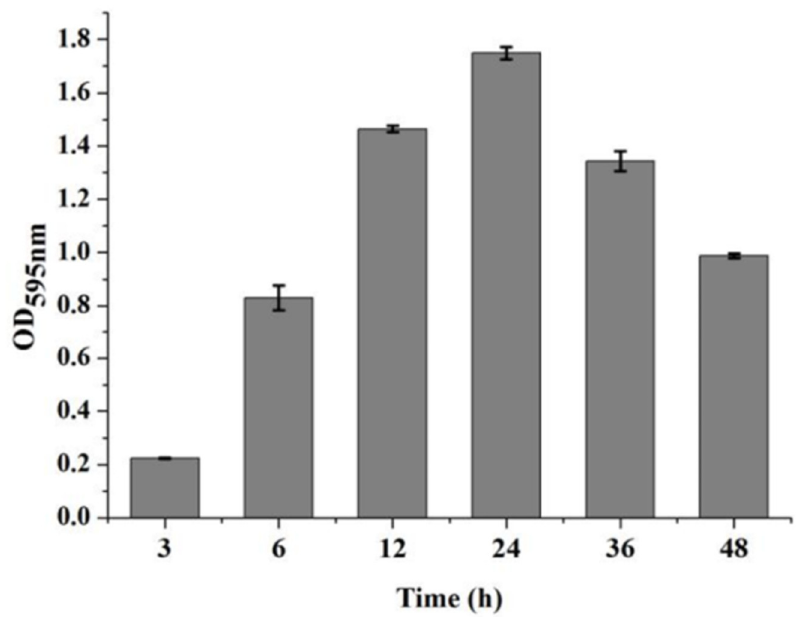
Figure 1. The dynamic development of V. parahaemolyticus biofilm formation incubated in 24-well microplates. Three technical replicates and three biological replicates were conducted.